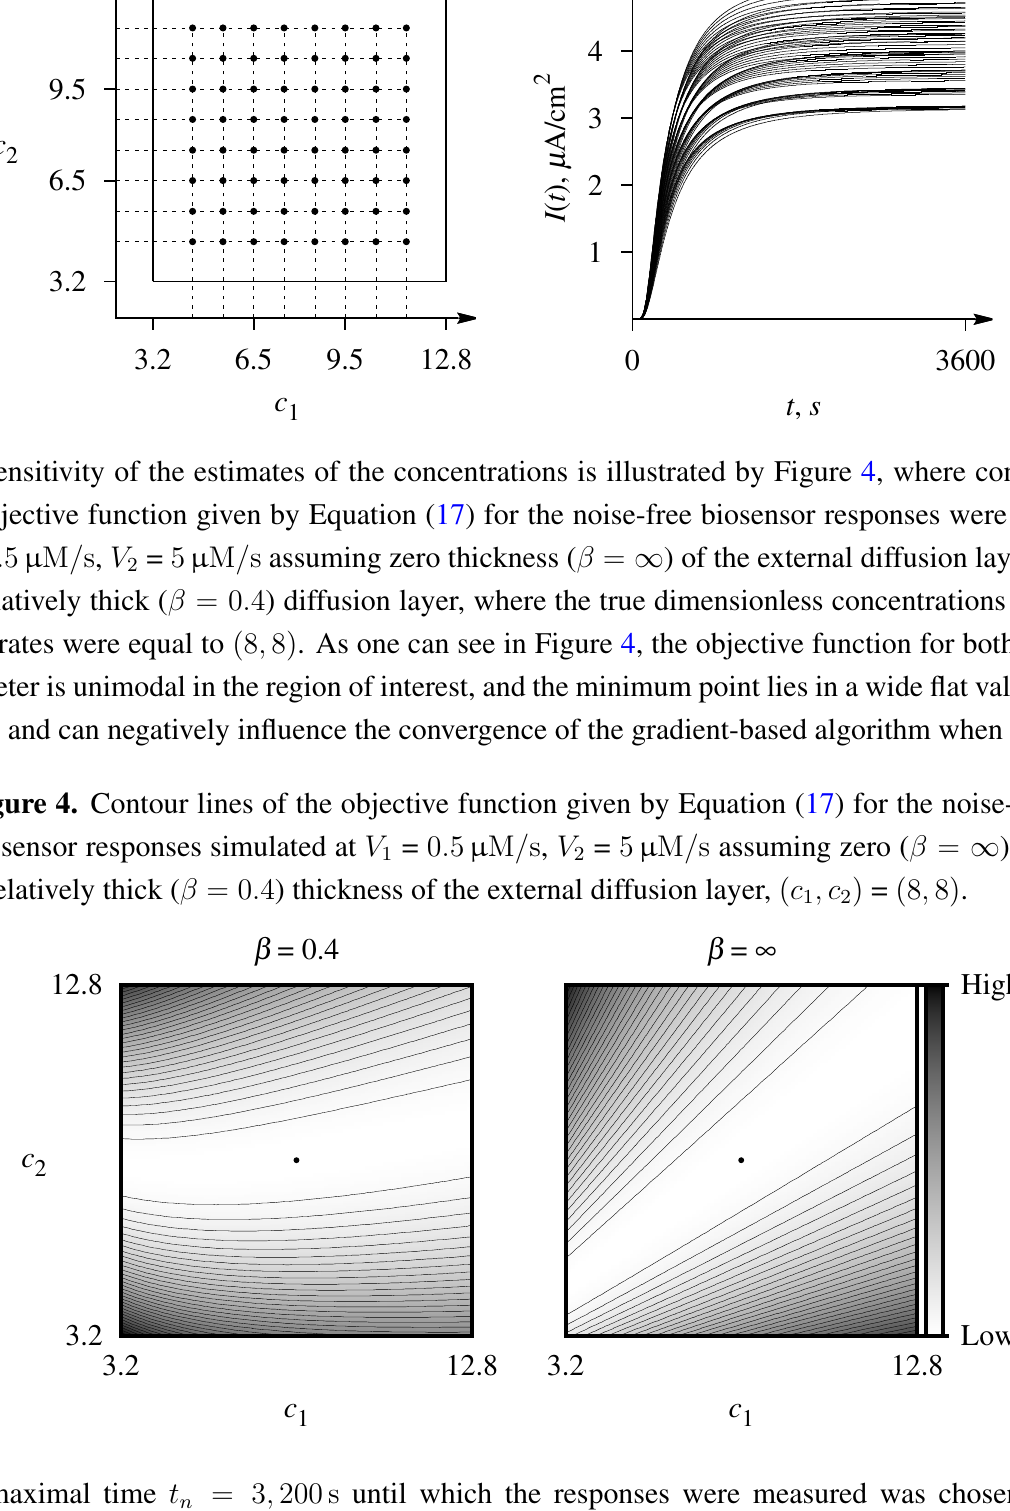
Figure 3. The set of the dimensionless concentrations, c used in the investigation, as well as the noise-free biosensor responses to these concentrations simulated at and V